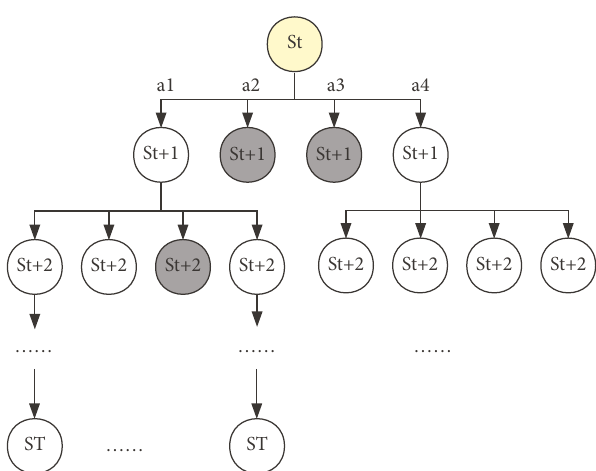
t means current state,